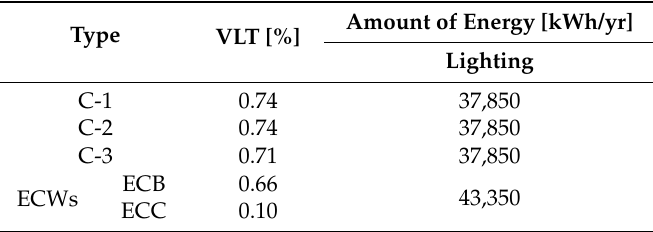
Table 7. Lighting energy analysis